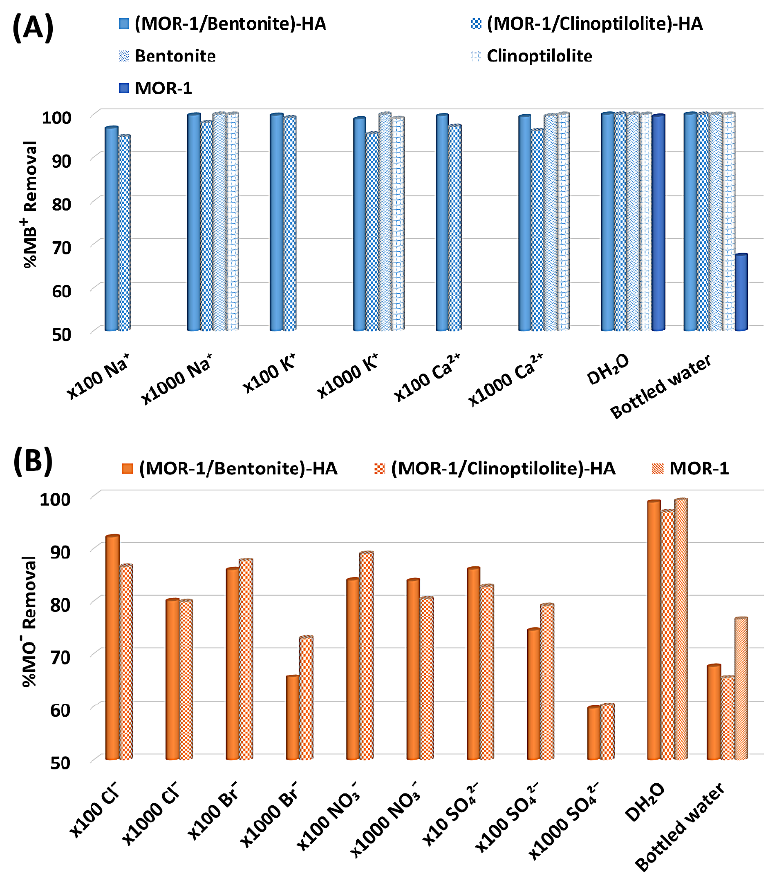
Figure 9. ( A ) MB + sorption data for (MOR-1/Bentonite)-HA and (MOR-1/Clinoptilolite)-HA in the